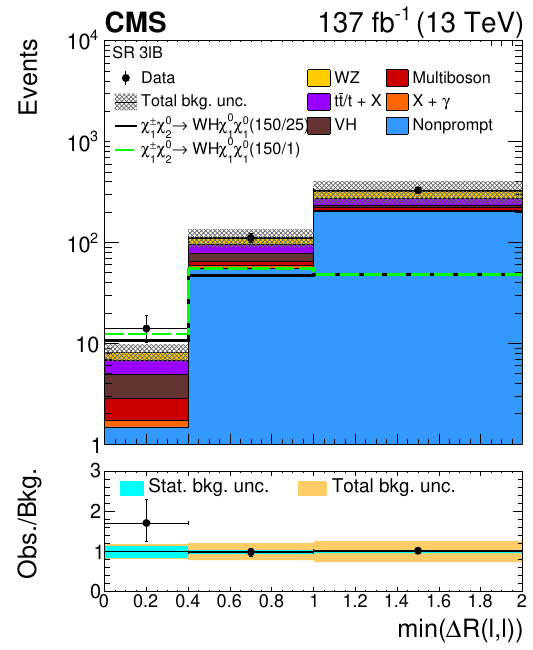
Figure 9 . Observed and expected yields across the search regions in events with three light leptons, none of which form an OSSF pair (3 ‘ B). Several signal models are shown superimposed. ± 0 They correspond to production with WH -mediated decays for scenarios corresponding to a H e c 2 1 e c boson like mass splitting δm = 125 GeV (black line) and a slightly less compressed δm = 150 GeV (green dashed line) scenario. The legends specify the masses of distributions as ( m / m 0 0 e c e c 2 1